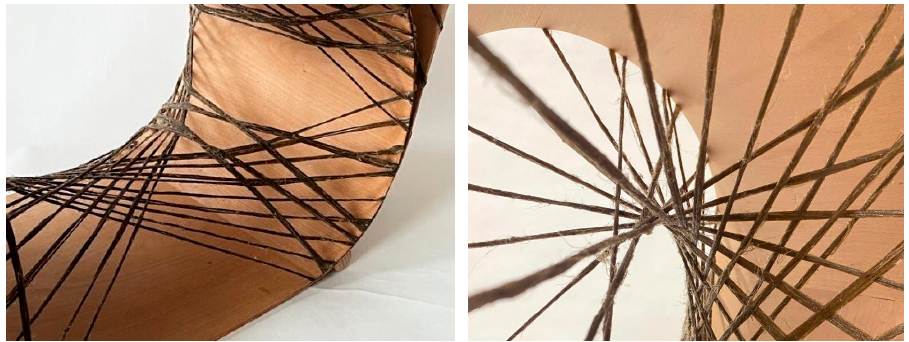
Figure 20. Details of final prototype.